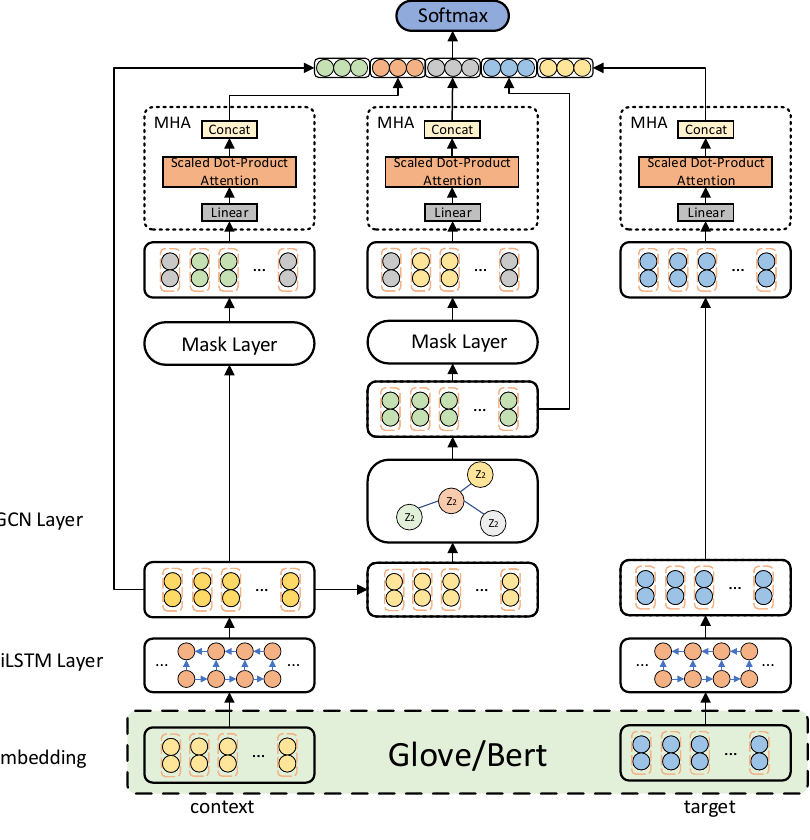
Figure 2. The overall architecture of the attentional interactive encoder network